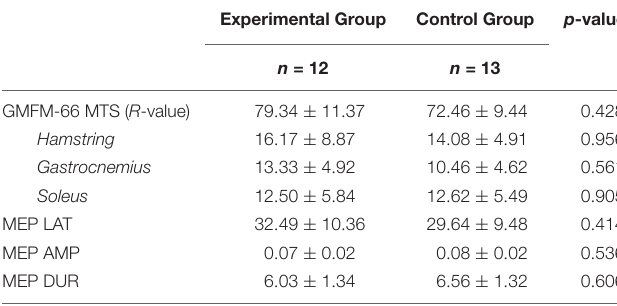
TABLE 2 | Outcome scores at baseline (mean ± SD). Experimental Group Control Group